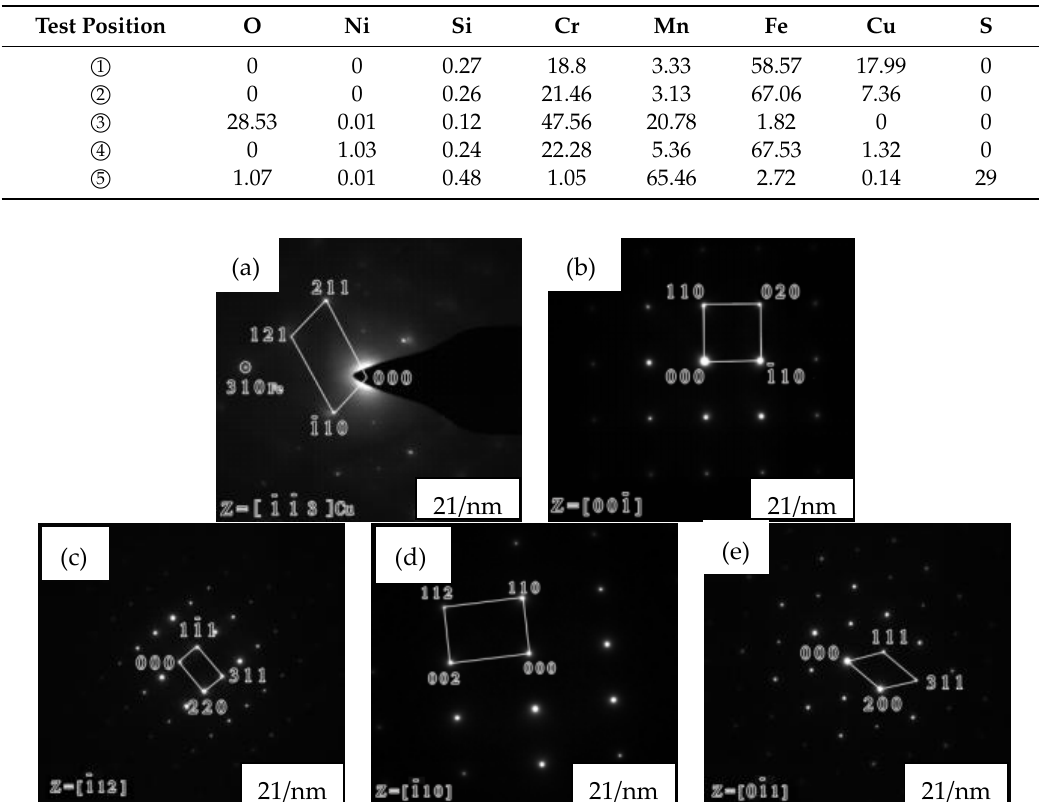
Figure 5. The selected diffraction spots of SX-750 and SX-850: a ) SX-750, region 2; b ) SX-750, region 3; c ) SX-850, region 1; d ) SX-850, region 2; e ) SX-850 region 3.